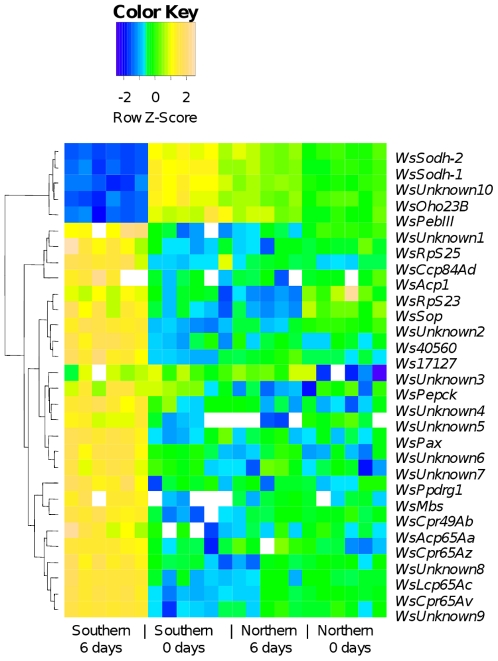
Gene expression that is regulated by differential physiological response to day length.Cell color denotes expression level standardized within genes across all experimental treatments relative to a reference sample; white cells represent missing data. The four different treatments from Figure 2B are represented along the bottom of the figure. Note that all of the genes presented here have a different pattern of expression in the single treatment generating a long-day response (Southern day 6) compared with the other three treatments.